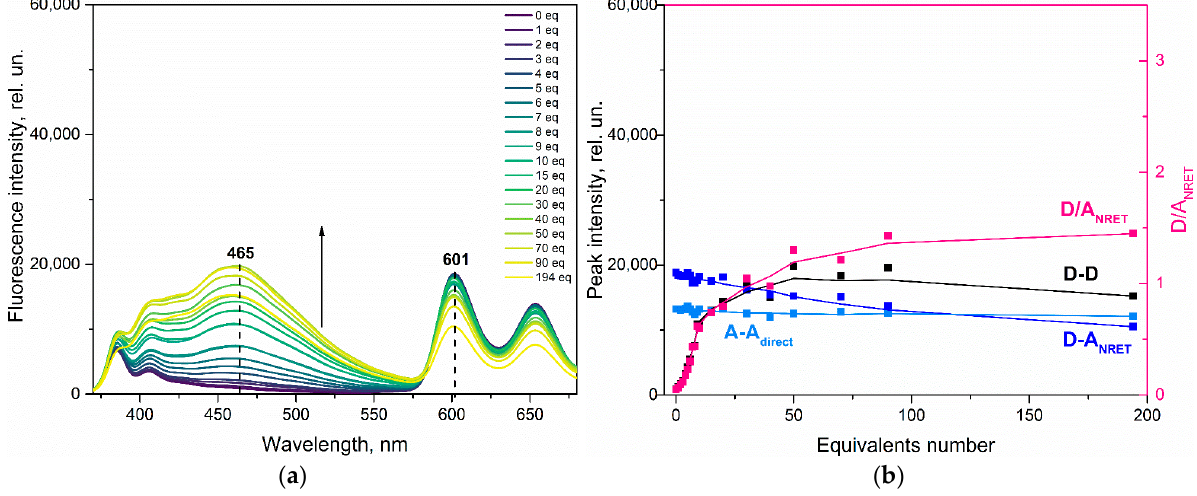
Figure 8. ( a ) The fluorescence titration of ZnPIP (7.9 × 10 − 7 M) with TNP (0–194 eq) in toluene ( λ ex = 346 nm). ( b ) The calibration plot for ZnPIP response to NB : D-D curve for the intrinsic D emission under λ ex = 346 nm, A-A direct for the intrinsic A emission under λ ex = 550 nm, D-A NRET for the A emission under λ ex = 346 nm, D/A NRET for the ratio between D-D and D-A NRET curves.